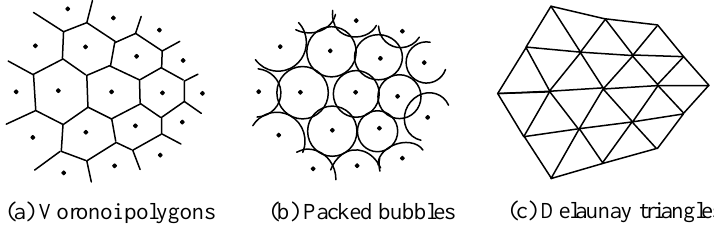
Figure 1. Illustrations of Delaunay triangles, Voronoi polygons, and packed bubbles.